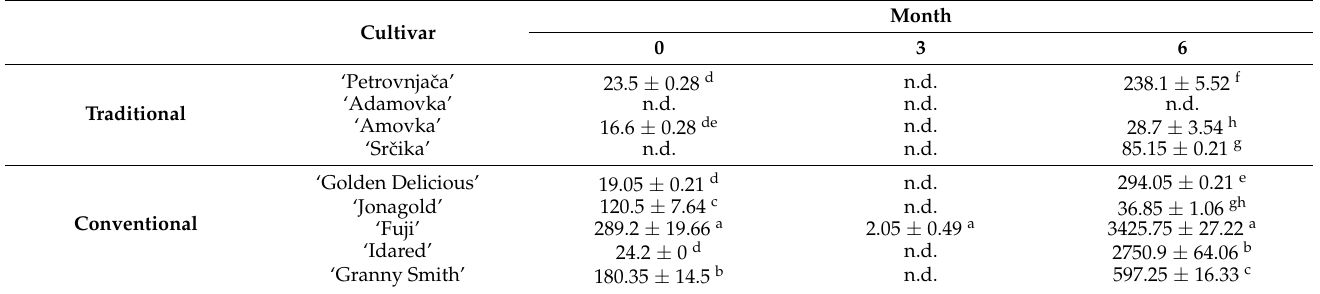
Table 7. The content of patulin ( µ g/kg dw a ) in the traditional and conventional apple cultivars. Cultivar